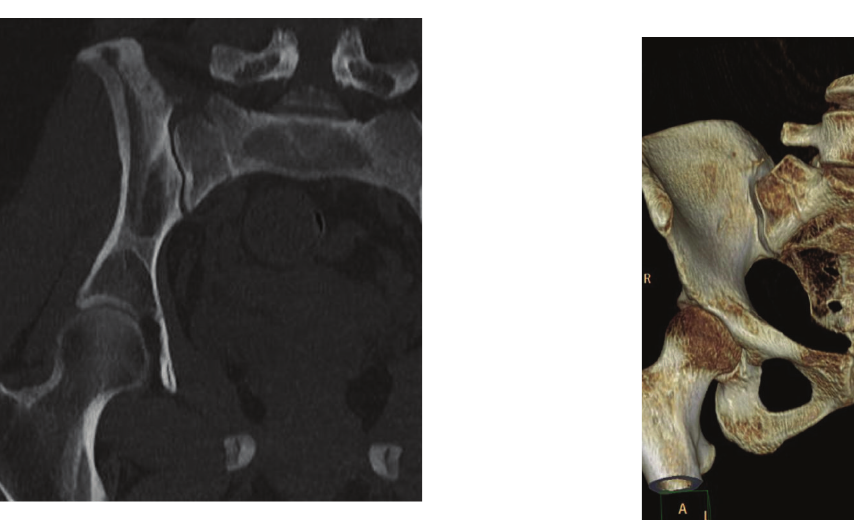
Figure 2: CT scan: coronal view of the right pelvis that showed the fracture line from the superior to the inferior border of the sacral bone with disruption of the cortical bone.